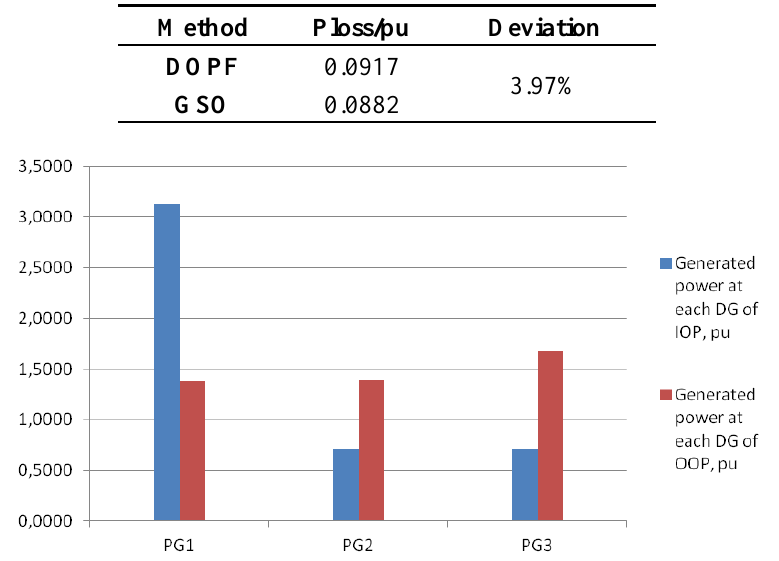
Figure 4. Change of generated power at each DG from IOP to